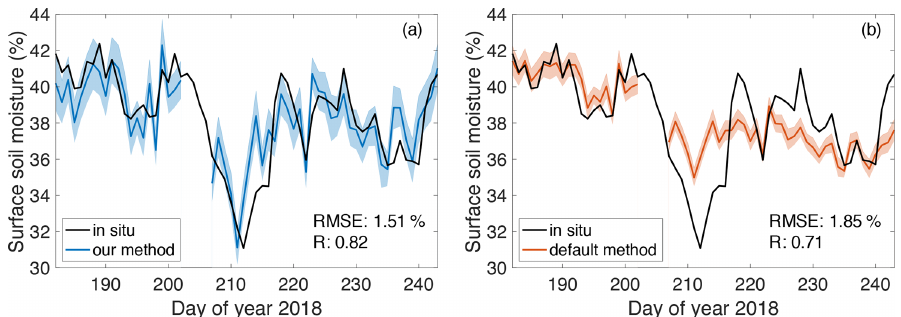
Figure 8. Time series of in situ soil moisture content and those measured by (a) our method and (b) the default method. The shaded areas denote the uncertainties of GPS-IR estimates. Root-mean-square error (RMSE) and correlation coefficient ( R ) are